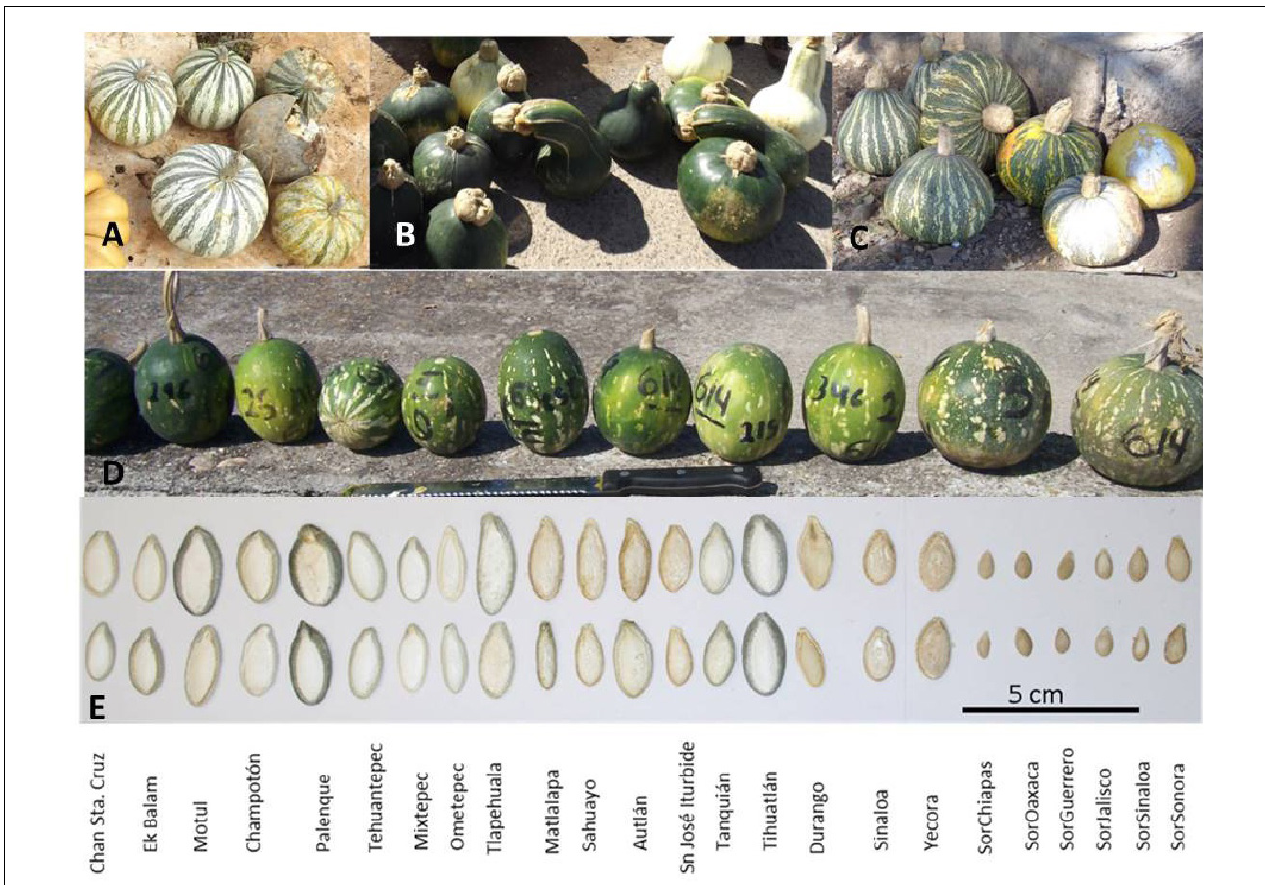
FIGURE 1 | Morphological characteristics of subspecies C. argyrosperma ssp. argyrosperma from Yucatán (A) , Sonora (B) and Jalisco (C) , and C. argyrosperma ssp. sororia (D) from Jalisco. Seeds from each population are shown at the bottom (E) . Population ID is shown in Table 1